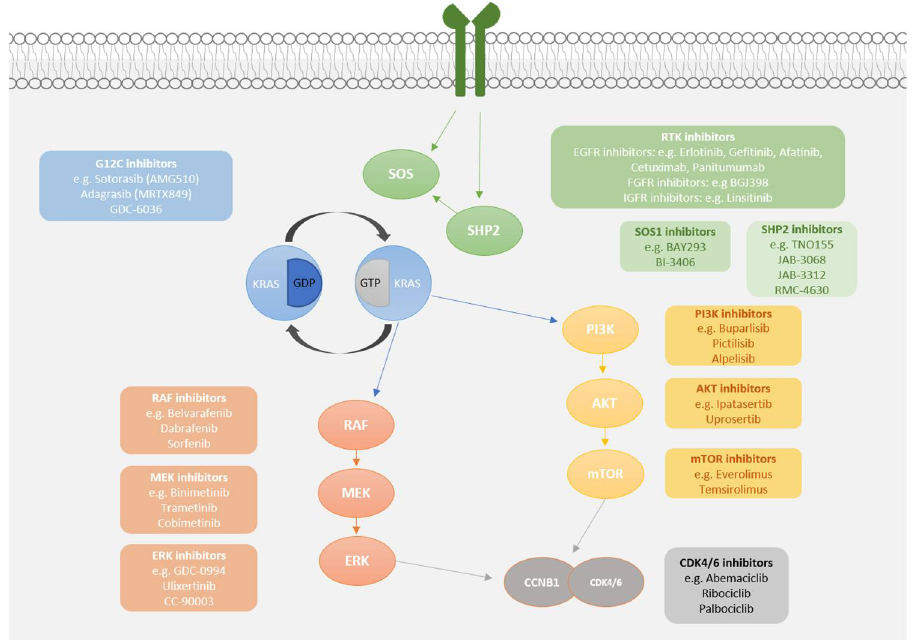
Figure 1. KRAS G12C potential co-inhibitory targets.